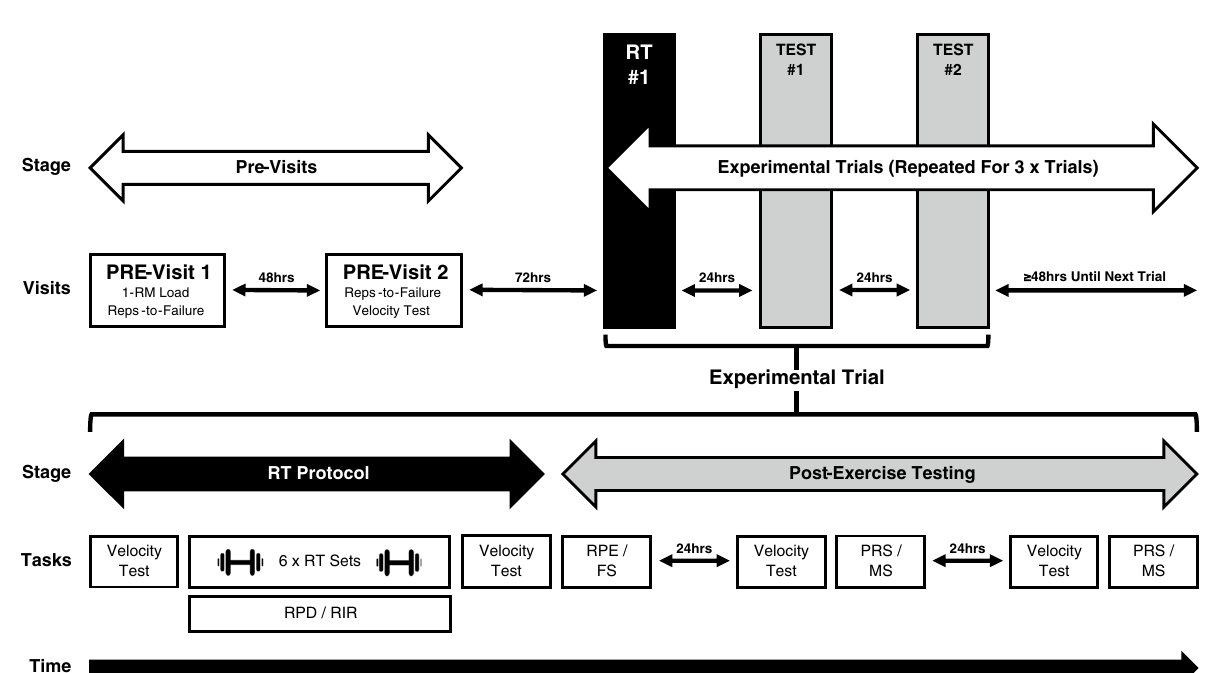
Fig. 1 Schematic overview of study design and experimental trials. Participants completed two pre-visit sessions and three experimental trials. Each trial consisted of a resistance training protocol (FAIL, 1-RIR, or 3-RIR) involving six sets performed on the barbell bench press exercise (75% 1-RM load), whereby changes in lifting velocity were assessed from the first to the final set and from pre-exercise to 4 min post-exercise. RPD was assessed after the completion of each set, and RPE and FS were assessed after the completion of the RT protocol. Following the RT protocol, two testing sessions 24 and 48 h thereafter were also completed to assess the recovery time course of lifting velocity, MS, and PRS. FS, feeling scale; MS, muscle soreness; PRS, perceived recovery status; RIR, repetitions-in-reserve; RPD, rating of perceived discomfort; RPE, rating of perceived exertion; RT,